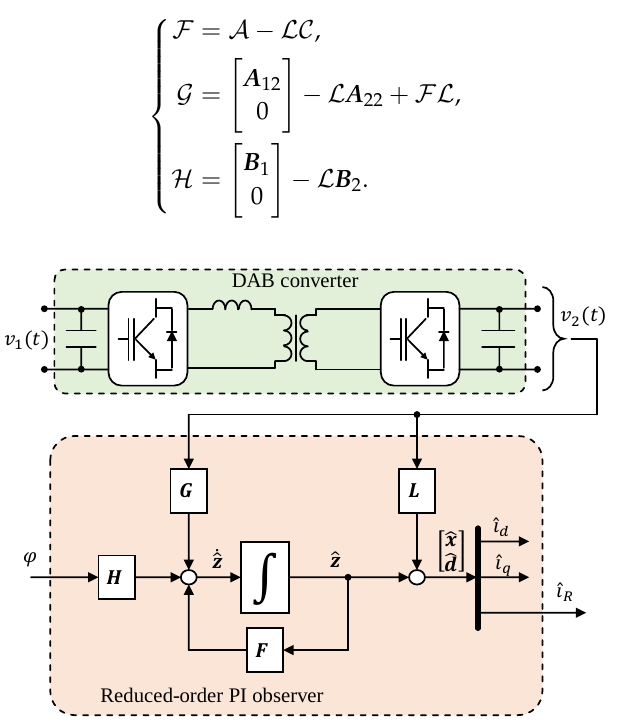
Figure 3. Observer diagram.